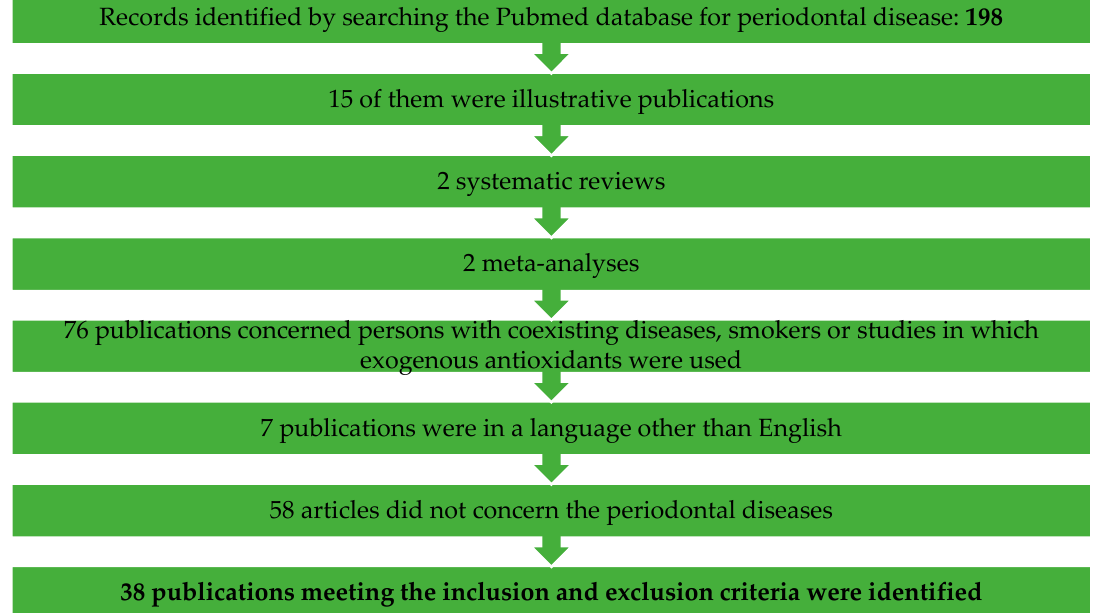
Figure 6. Flow chart of the study selection process for the systematic review regarding periodontal diseases.